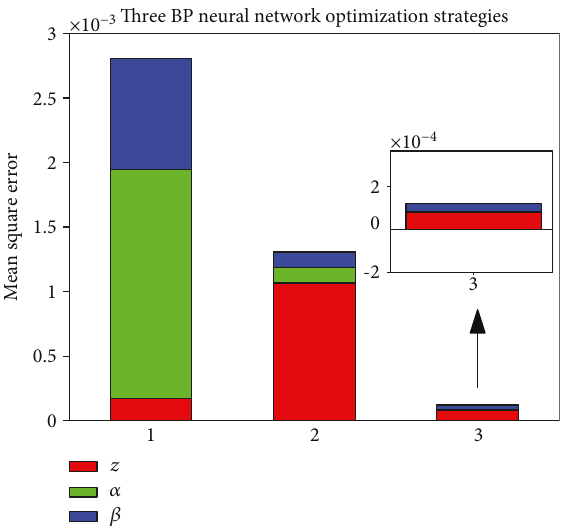
Figure 7: Bar chart comparison of the three output parameters.